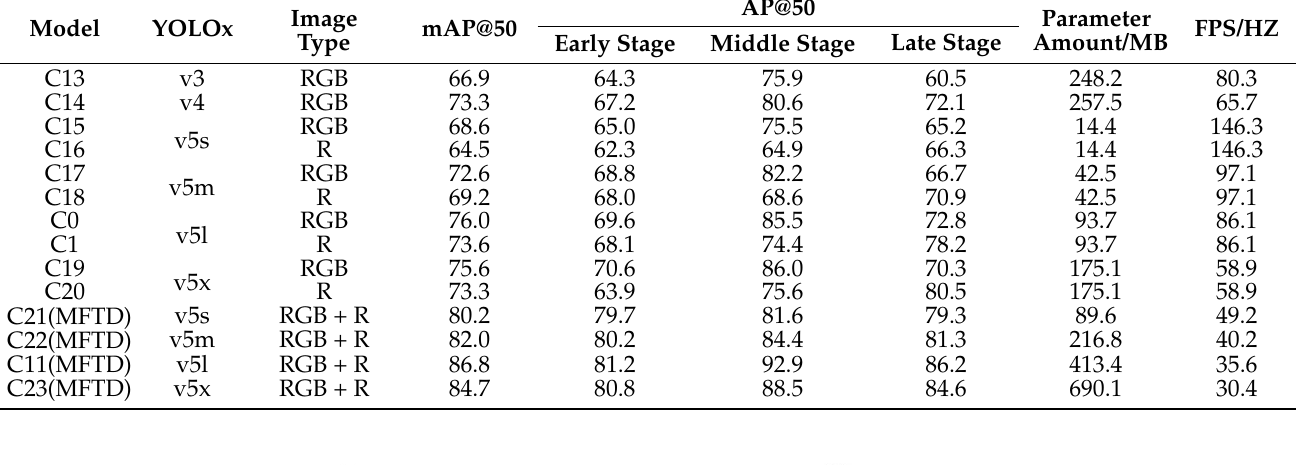
Table 9. Detection performances of YOLO series and MFDN on CP Dataset.